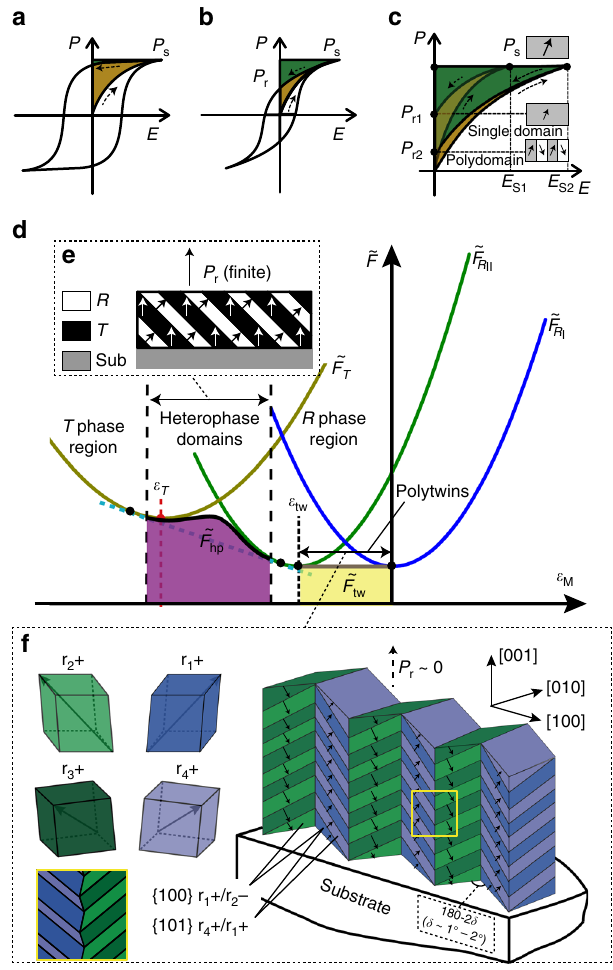
Fig. 1 Energy storage in ferroelectrics and optimal design of their domain structures. a A normal ferroelectric P – E loop, b a slim ferroelectric P – E loop, and c P – E loops (partially shown) for a single-domain and an engineered polydomain ferroelectric fi lm. The green-shaded areas represent the recyclable energy densities, while the shaded areas within the loops are the (cid:1) (cid:3) energy losses of one charge – discharge cycle. d Free energies ~ F vs. mis fi t strain ε M for a fi lm with a single-domain rhombohedral phase ( R I , ~ F R or R II , I ~ F ~ F (cid:1) (cid:3) R II ), a single-domain tetragonal phase ( T , T ), T / R heterophase ~ F ; and rhombohedral polytwins ( R polydomains ~ F hp I / R II , tw ). Stable regions of the polydomain structures are determined by the common tangent method applied to the free energy curves of single-domain fi lms. ε T and ε tw are the spontaneous strains of the T and R II domains with respect to the R I domain. Schematics of the polydomain structures are shown in e for a T / R heterophase polydomain, and f for hierarchical rhombohedral polytwins formed in a (001)-oriented epitaxial ferroelectric fi lm with a bulk rhombohedral